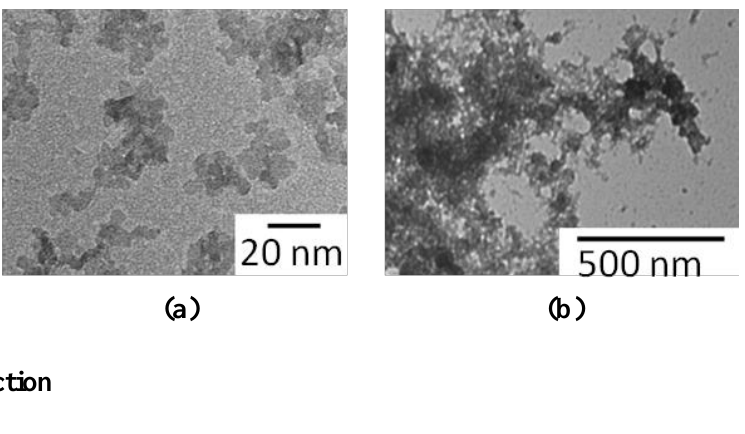
Figure 9. (a) TEM image of nanoparticles synthesized in methanol at a pH of 3; (b) TEM image of nanoparticles synthesized in methanol at a pH of